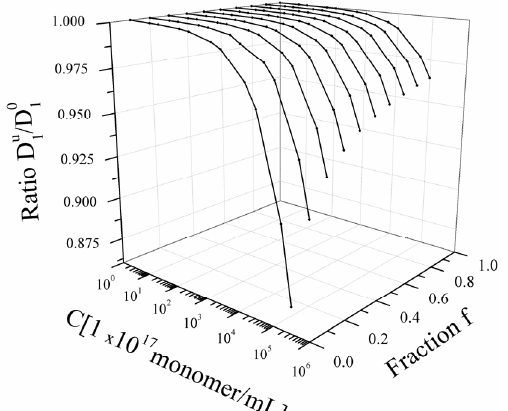
Figure 4. Bead-controlled regime. Dependence of the ratio 0 concentration C and on the fraction f for a fixed value of the solvent quality parameter ( τ =